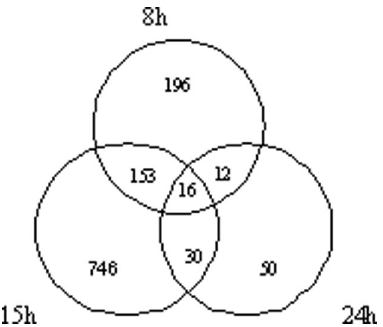
Figure 4. Number of common differentially expressed genes between different time points